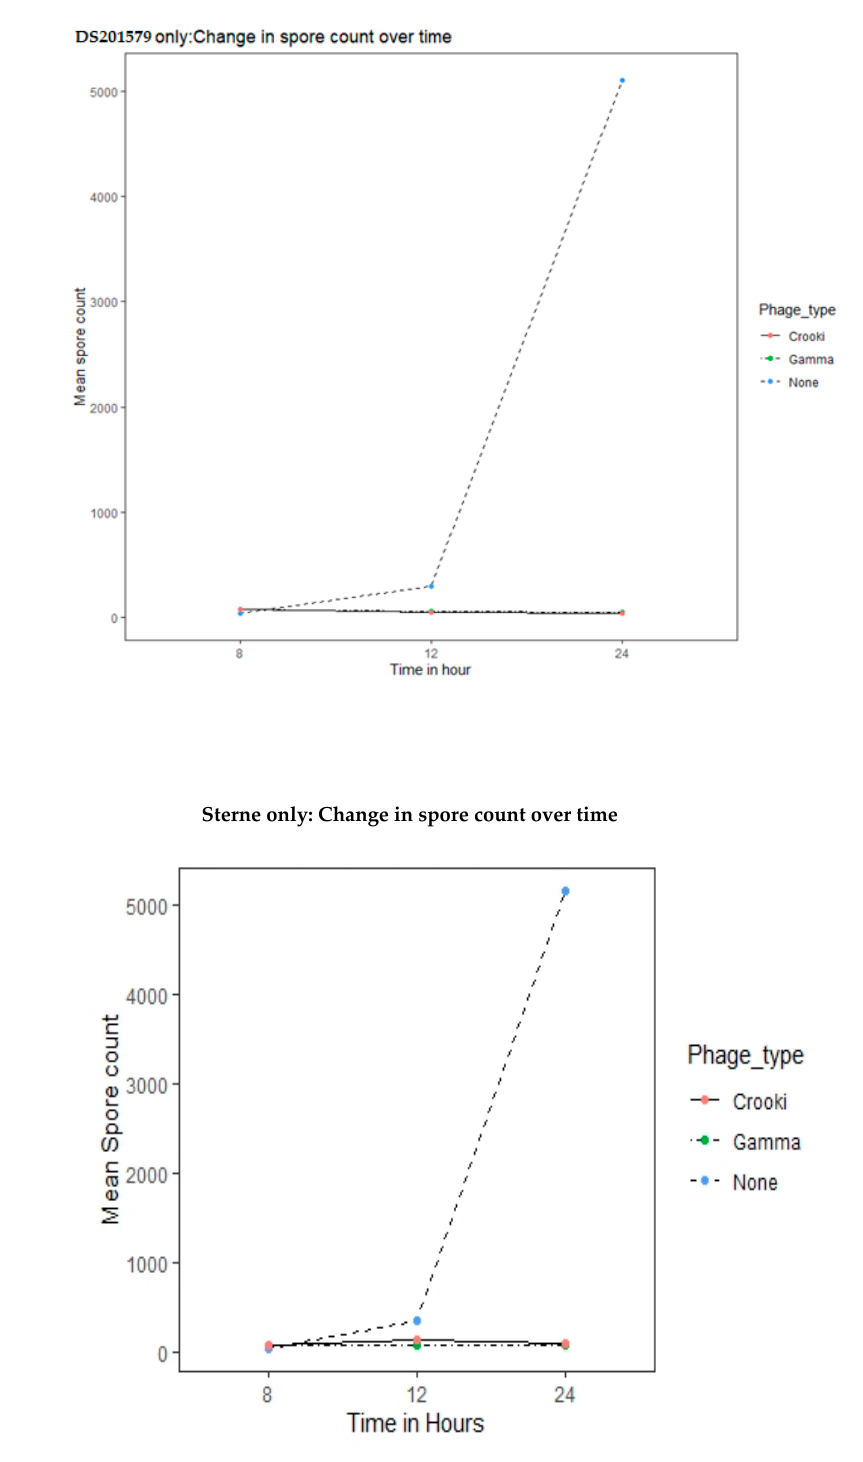
Figure A4. ( A ): Change in cell counts for Bacillus anthracis strain DS201579 under normal conditions and when inoculated with Gamma phage. ( B ): Change in cell counts for Bacillus anthracis Sterne strain under normal conditions and when inoculated with Gamma phage. ( C ): Change in spore counts for Bacillus anthracis strain DS201579 under normal conditions and when inoculated with Gamma phage. ( D ): Change in cell counts for Bacillus anthracis Sterne strain under normal conditions and when inoculated with Gamma